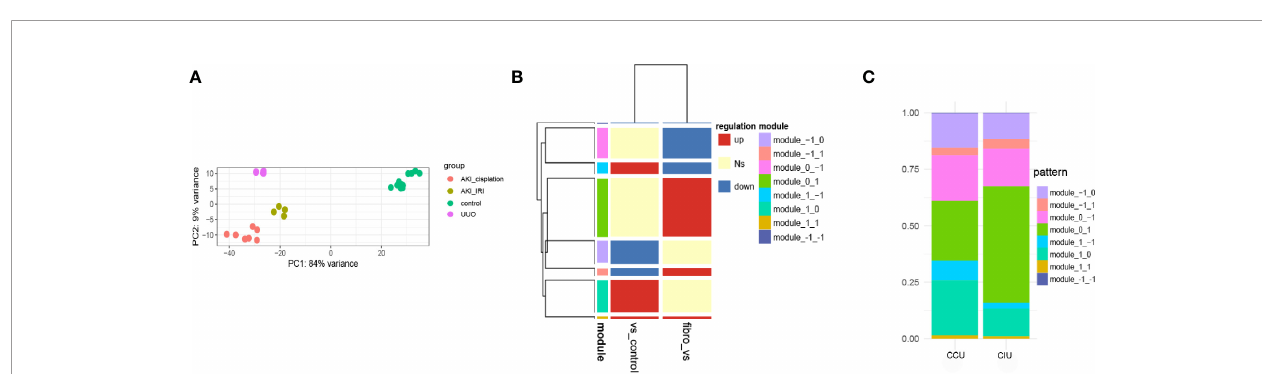
FIGURE 2 | Dynamic gene expression patterns in acute kidney injury (AKI)-to- fi brosis progression. (A) Principal component analysis of all datasets. (B) Gene expression modules in AKI development and deterioration Fibrosis samples were compared within AKI samples and between AKI and healthy samples. Up shows increased differentially expressed genes (DEGs), down shows decreased DEGs, and Ns shows DEGs that have no signi fi cant difference in the comparison. (C) The distribution of each module in different AKI progressions. CCU, from healthy to cisplatin-induced AKI to fi brosis; CIU, from healthy to IRI-induced AKI to fi brosis. All data are available at GEO database (GSE10669, GSE145053, GSE153625).